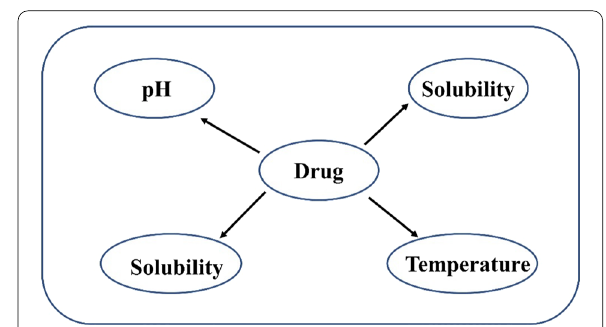
Fig. 3 Drug release mechanism through